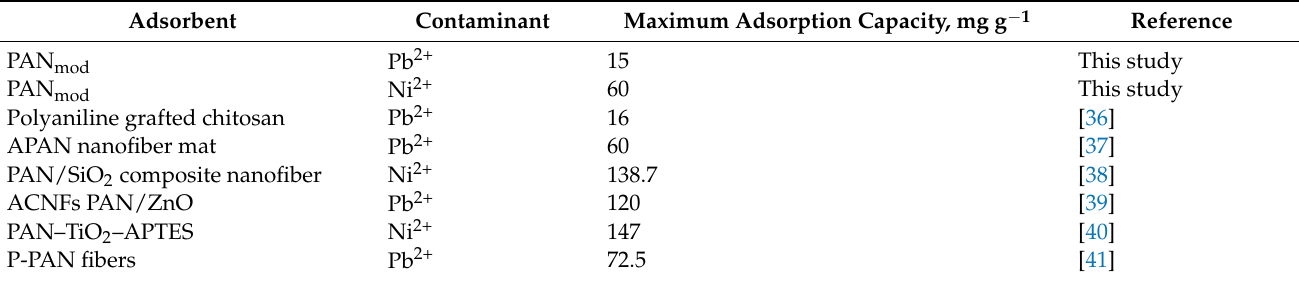
Table 2. Comparison of adsorption capacities of PANmod for Pb 2+ and Ni 2+ with other similar adsorbents. Adsorbent Contaminant Maximum Adsorption Capacity, mg g − 1 Reference